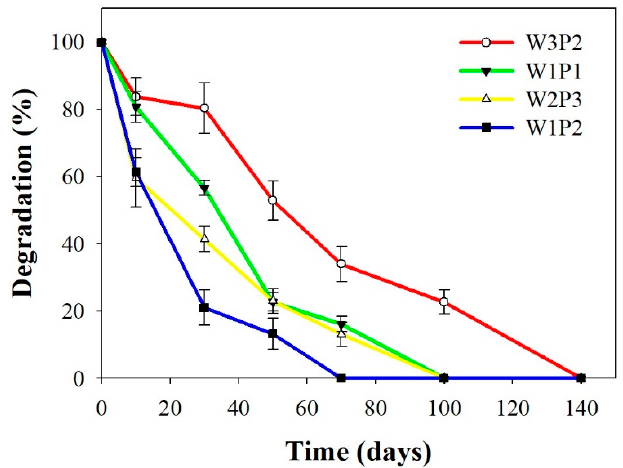
Figure 4. The in vitro degradation curves obtained at 30 °C for NFMs with different WPU/PEO volume ratios: W1P1 degradation took approximately 100 days.